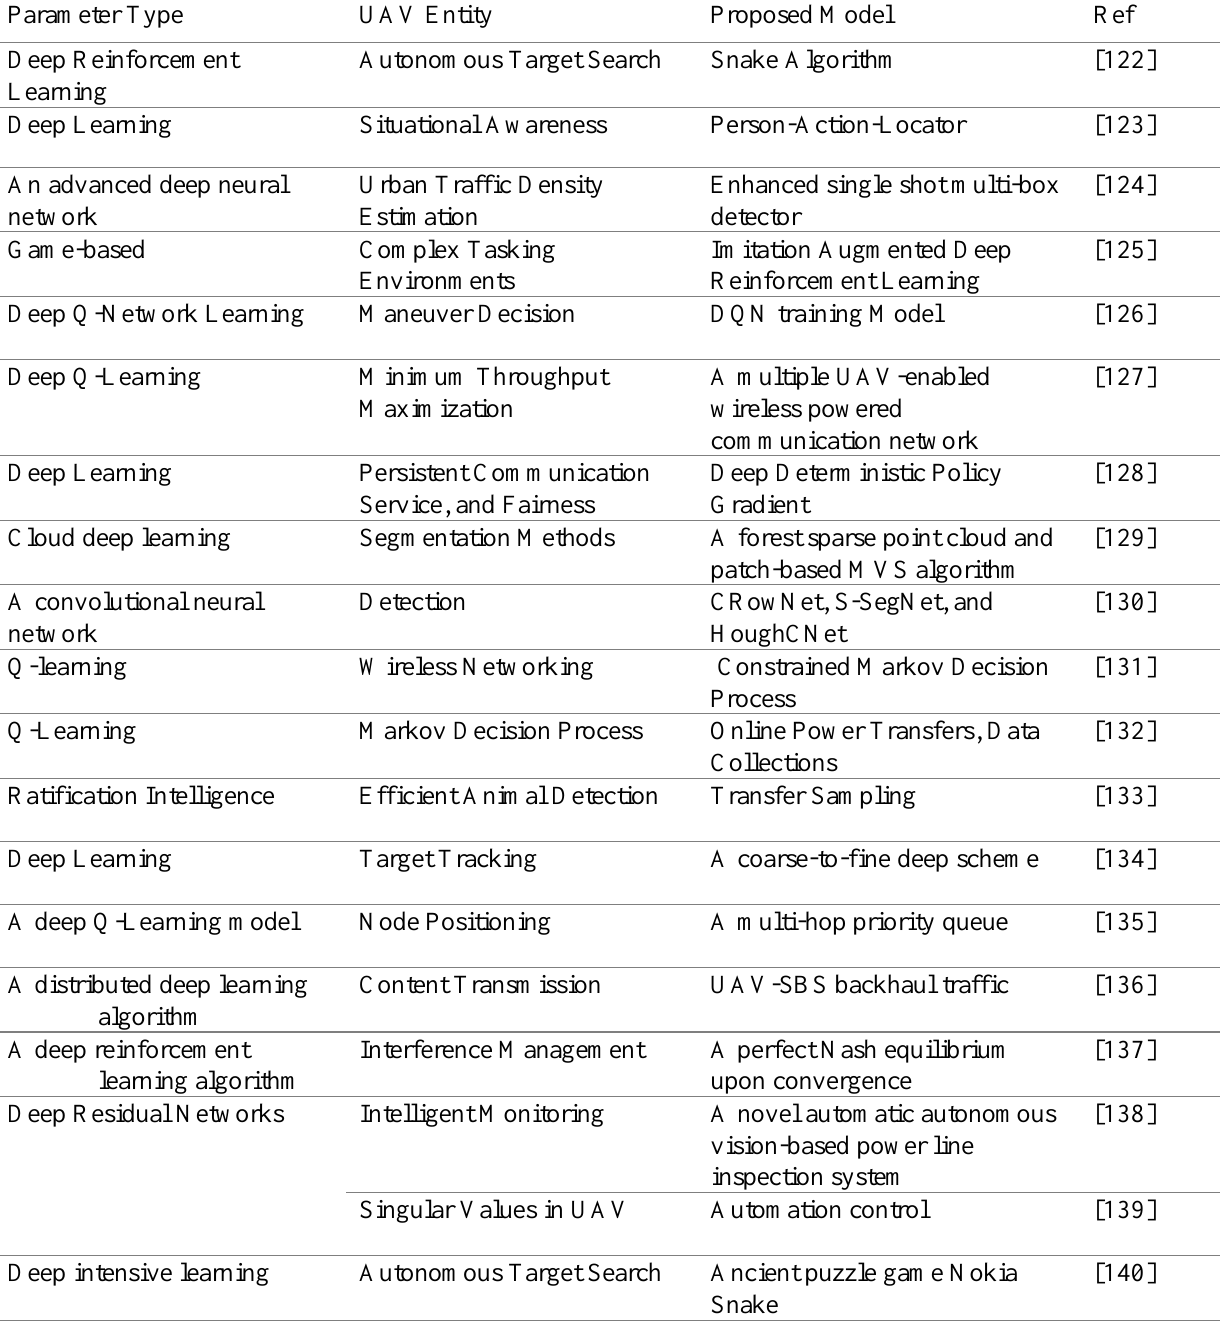
Table 6. The UAV trending key points, and modern UAV